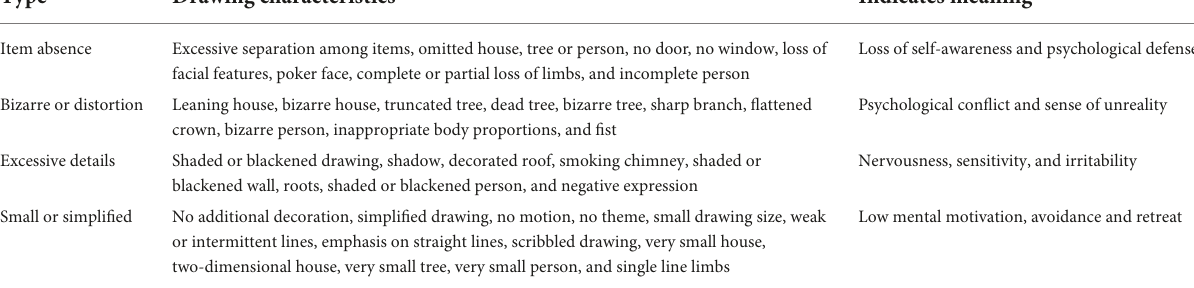
TABLE 5 Characteristics and implications of effective predictive drawing for mental